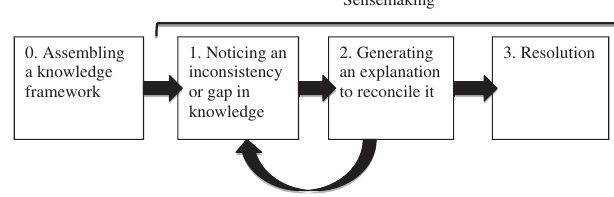
FIG. 4. Students ’ trajectory through the process of